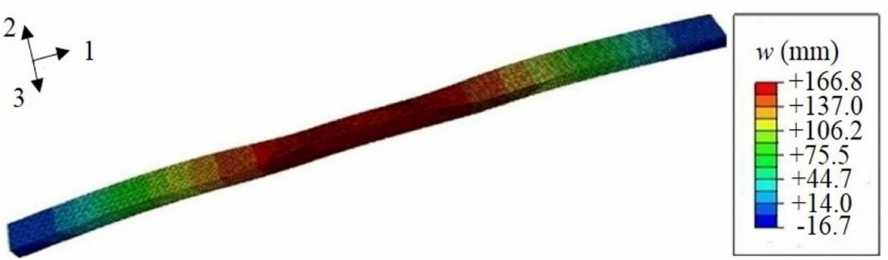
Figure 7. The deflection distribution diagram obtained from the FE simulation, where 1, 2, and 3 in the axis denote the length, thickness, and width direction of the composite leaf spring,